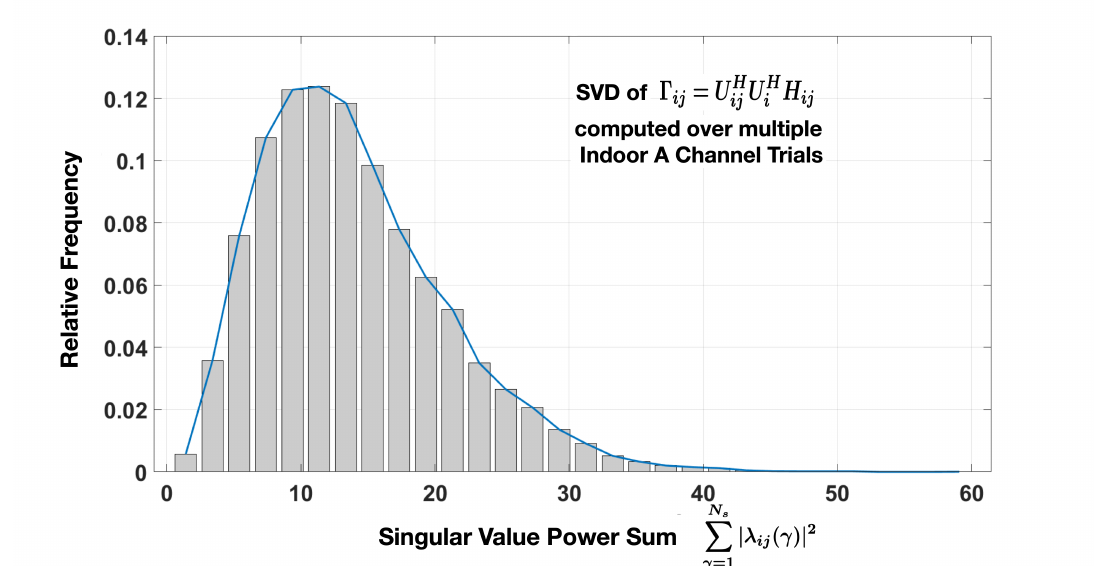
Figure A1. Relative frequency distribution of the singular value power sum for K = 3. The upper bound for this sum is given by Equation